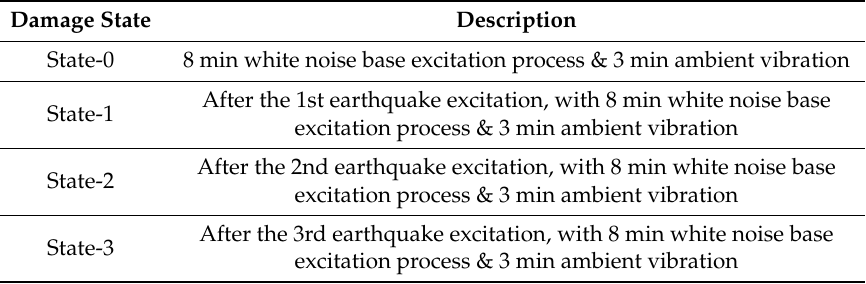
Table 1. Dynamic tests used in this study.